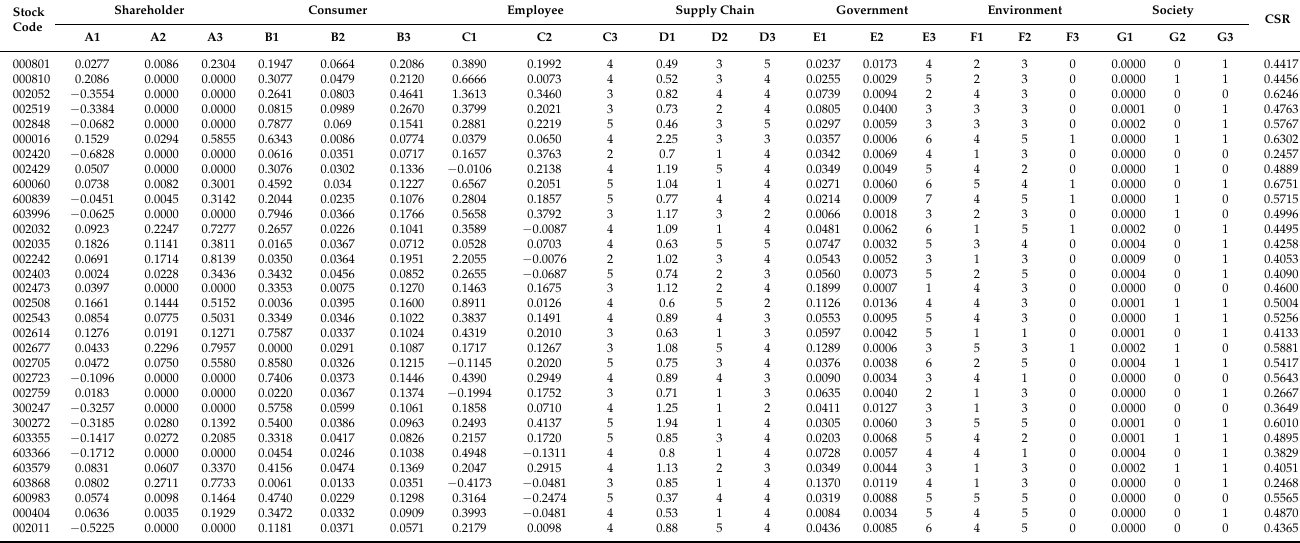
Table A1. Original data with symbols in Table 1 and CSR score of each sample company obtained via to the analytic hierarchy process (AHP)